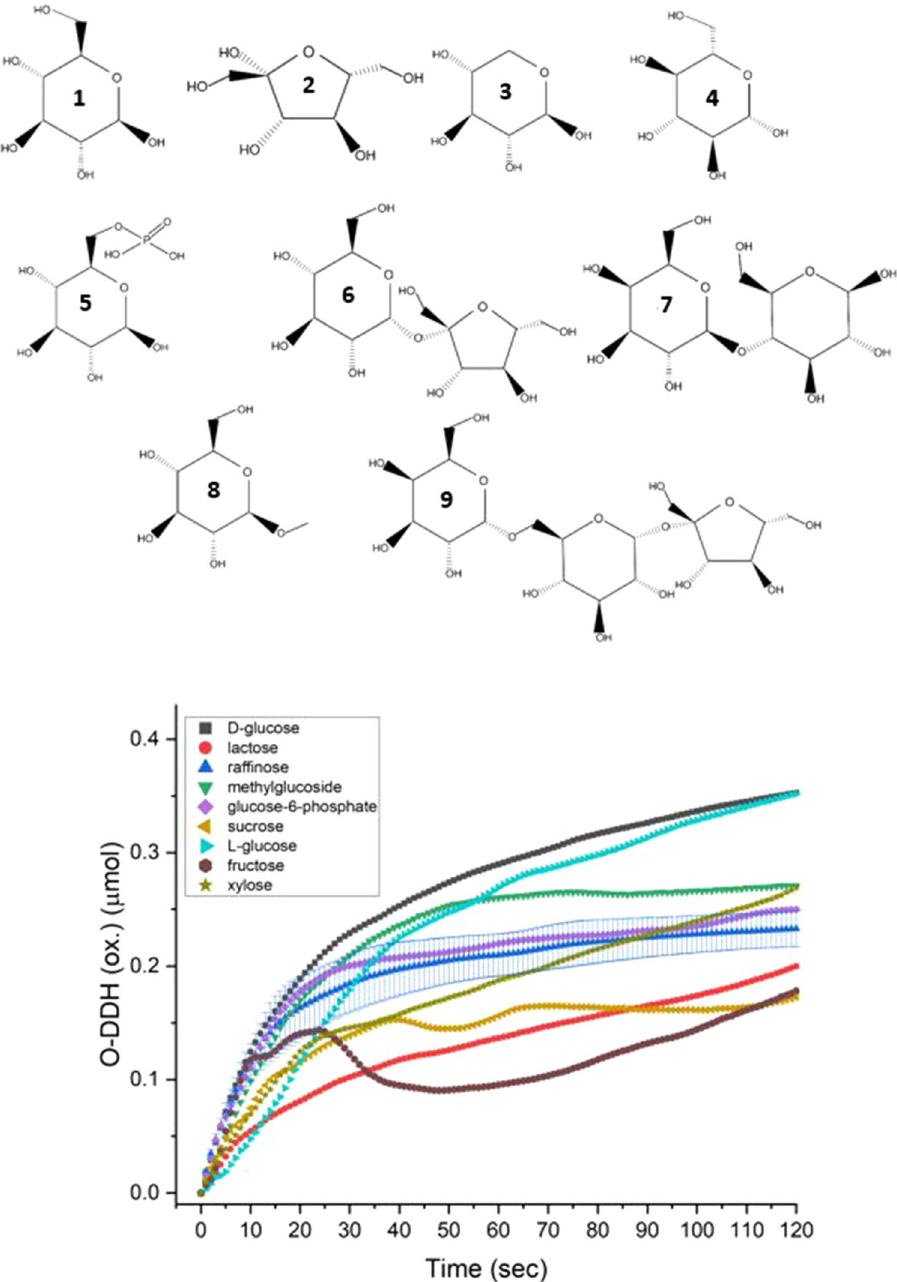
Figure 1. Top: structures of all of the saccharides used in the study—(1) d-glucose, (2) fructose, (3) xylose, (4) l-glucose, (5) glucose-6-phosphate, (6) sucrose, (7) lactose, (8) methylglucoside, (9) raffinose. Bottom: the activity of GOx/CTAB@Au with all of the saccharides, as a measure of oxidation of o-dianisidine (O-DDH). (Typical error bars are shown for raffinose. Error bars for methyl glucoside are shown in see Fig. 7 and for all other sugars in the Supplementary Material Figs.